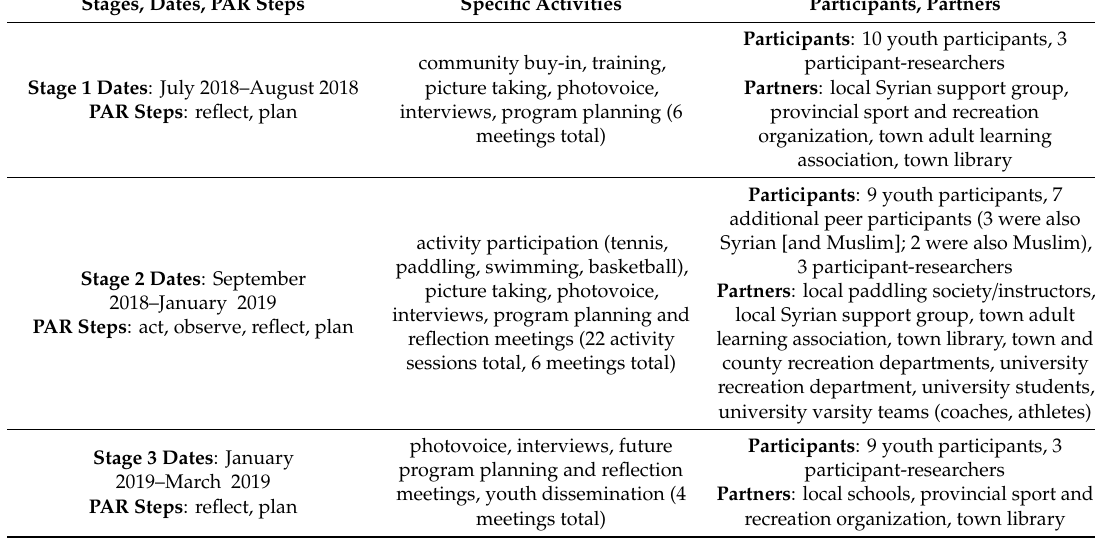
Table 1. Overview of stages, dates, PAR steps, specific activities, and participants and partners. Stages, Dates, PAR